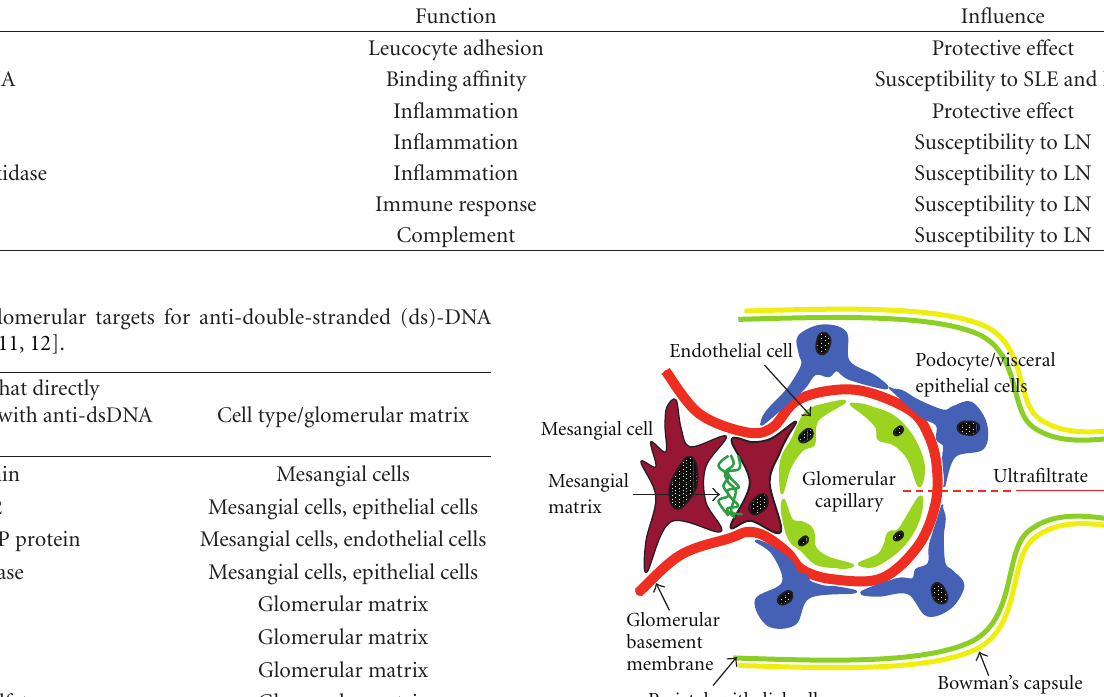
Table 1: Genes associated with lupus nephritis (LN) [4–10].